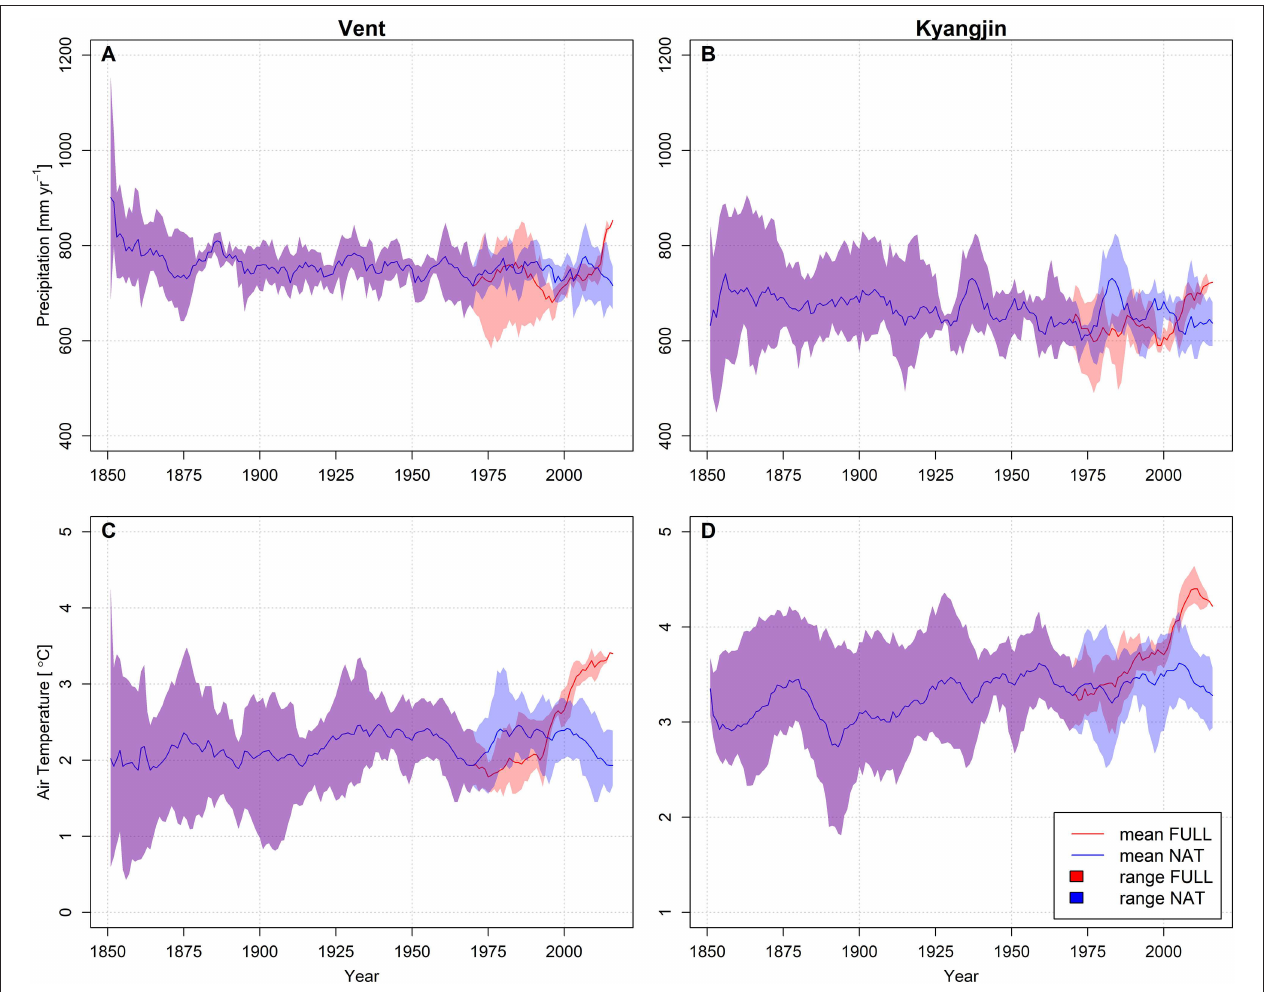
FIGURE 3 | 10-yrs moving averages of simulated precipitation (A,B) and temperature (C,D) changes for the period 1971–2016 for FULL (red) and NATURAL (blue). The moving averages are given for the Vent (A,C) and Kyangjin (B,D) stations. The colored bands denote the range of the